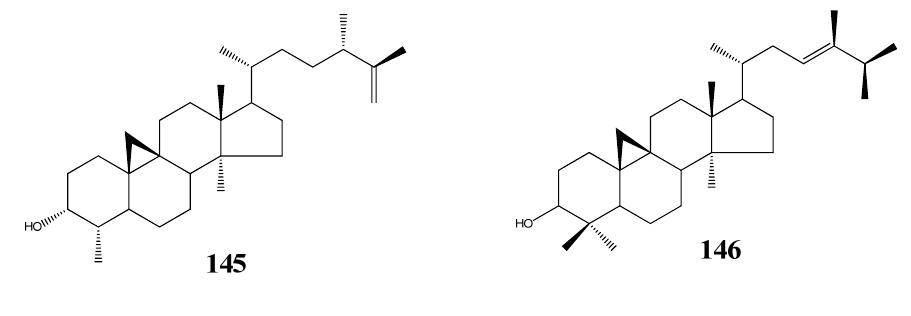
Figure 19. Cycloartane-type triterpenoids from marine algae.